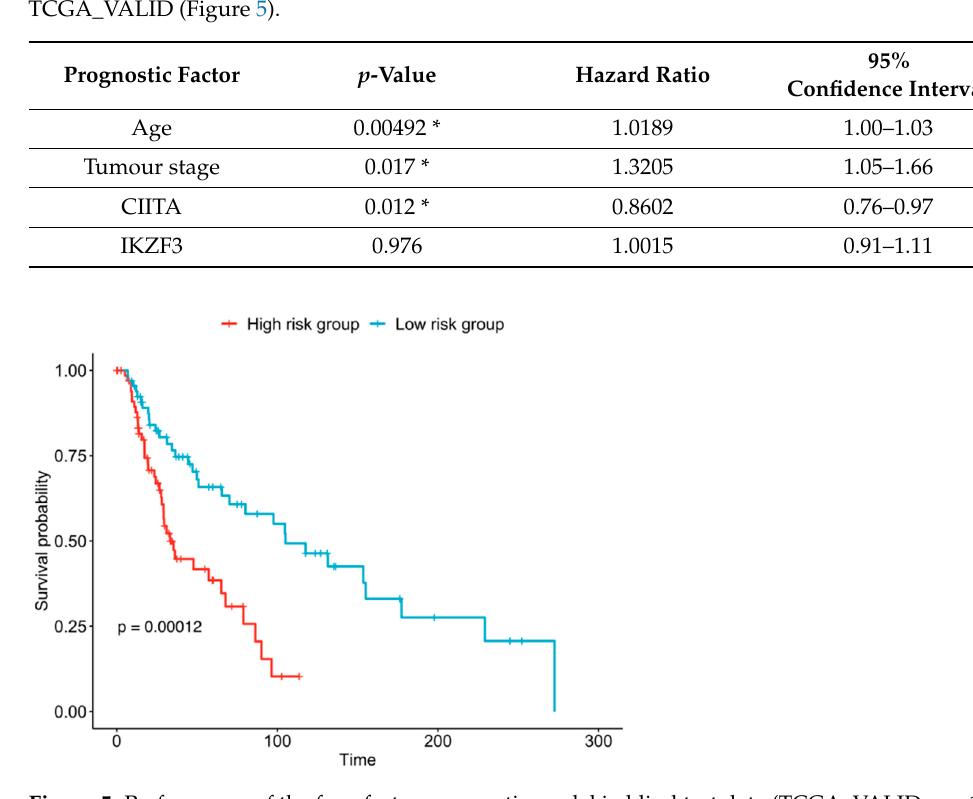
Figure 5. Performance of the four-factor prognostic model in blind test data (TCGA_VALID, n = 135). Melanoma patients were risk stratified by overall survival according to the variables Age, tumour stage, CIITA, and IKZF3. The x -axis shows time in months. The high-risk and low-risk groups have significantly different overall survival ( p = 0.00012).